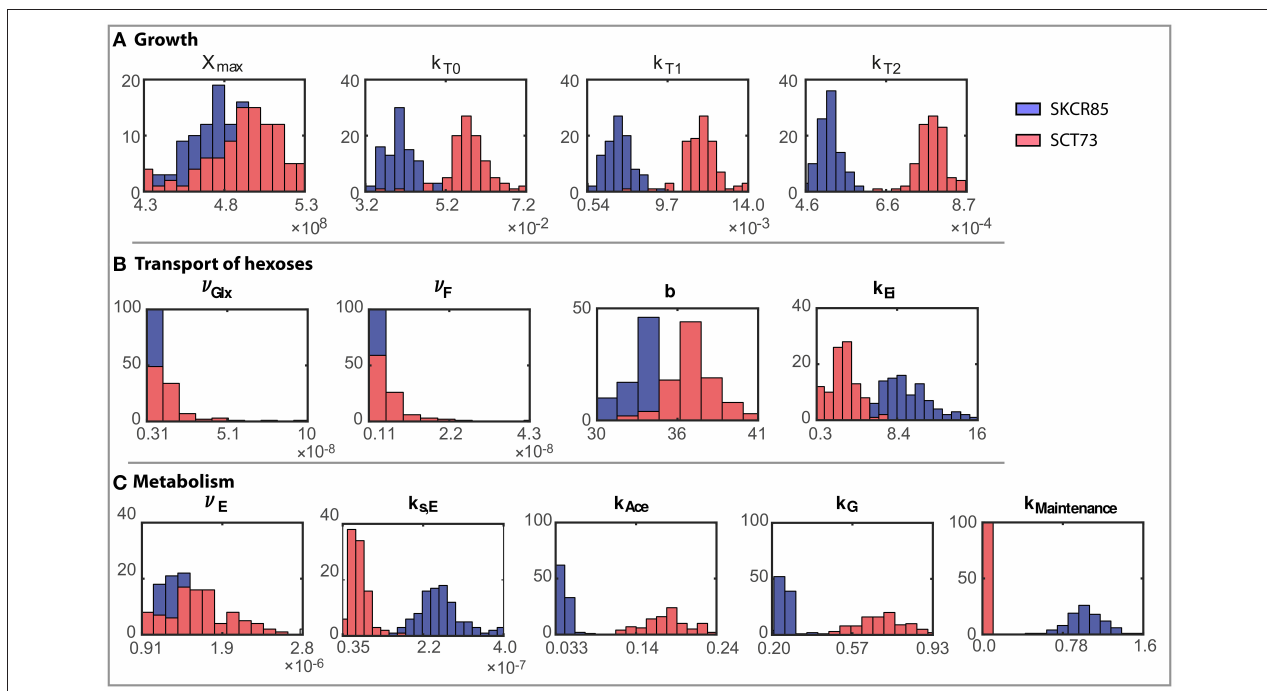
FIGURE 4 | Ensemble of parameter solutions resulting for the multi-experiment data fitting for both strains (model R3). Figures present a comparative analysis of the distributions of parameter values obtained for both species: (A) Parameters related to growth, (B) Parameters related to transport of hexoses, and (C) Parameters related to metabolism. Blue distributions correspond to SKCR85 and red distributions correspond to SCT73.